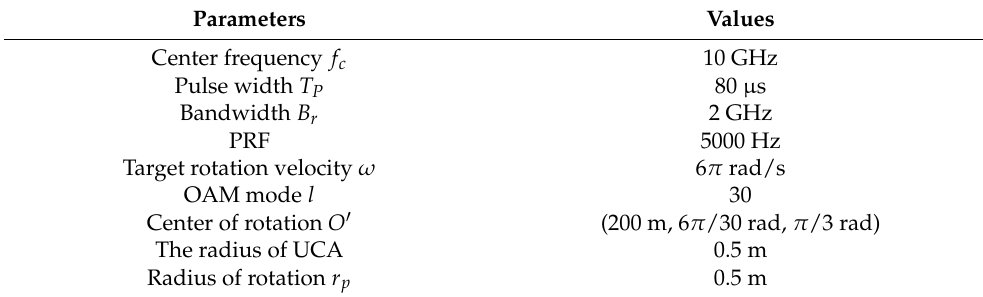
Table 1. Key parameters in the